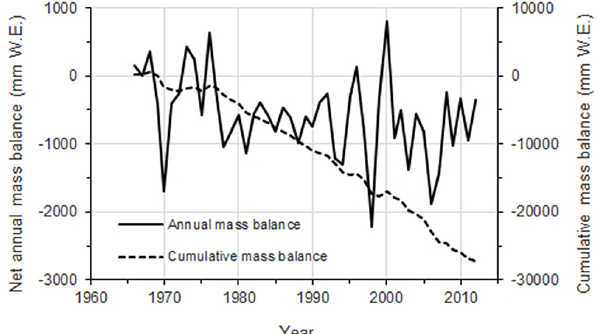
Figure 8. Net annual mass balance series for Peyto Glacier (1966– 2012) and cumulative mass balance over the 46-year period. Note that values in 1991/92 are reconstructed from proxy information and values in 2010–12 are preliminary (data provided by M. Demuth, Geological Survey of